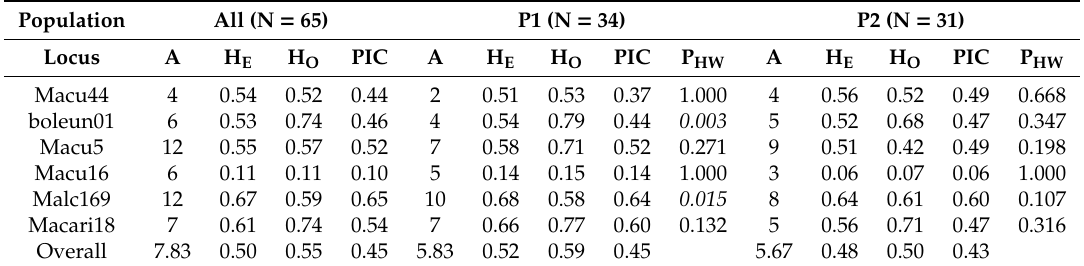
Table 4. Characterization of six microsatellite loci analysed in 65 individuals of Scolitantides orion from two Polish populations (P1 and